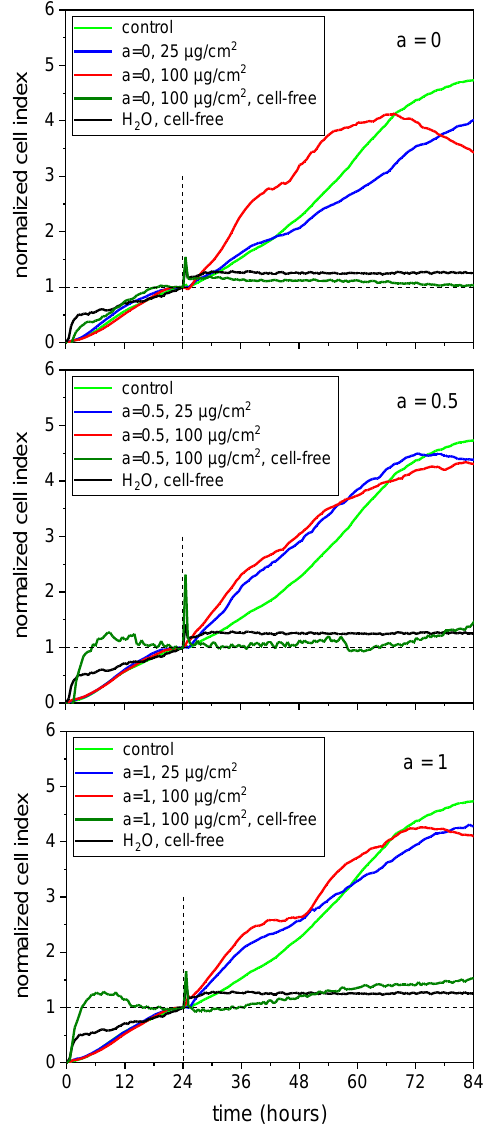
Figure 10. Real-time cell analysis confirmed no reduced viability of human brain microvascular endothelial cells (HBMECs) within 60 h for particles with an increasing Co content in comparison to the untreated control (green line); MNPs were added after 24 h which were indicated by the vertical dashed line. The basis of the normalized cell index was the 24 h value of the samples, respectively (horizontal dashed line). n = 2 technical replicates.